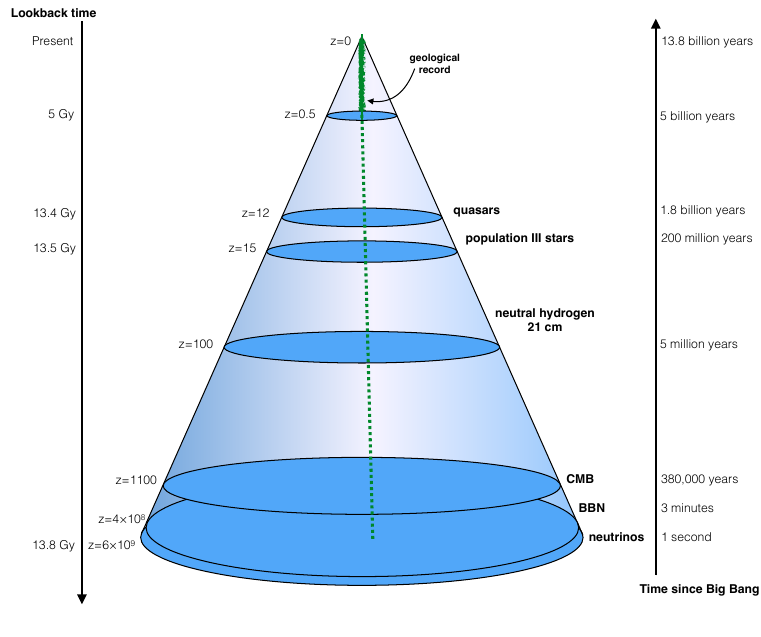
Figure 1. How we observe the universe. The lookback time is the difference between the age of the universe now, and the age of the universe when photons from an object were emitted. The more distant an object, the farther in its past we are observing its light. This distance in both space and time is expressed by the cosmological redshift z . We obtain most of our astrophysical information from the surface of our past light cone, because it is carried by photons. The only information from within the cone come from local experiments and observations, such as geological records. The green dotted line is the world-line of the atoms and nuclei providing the material for our geological data. Local experiments are carried out along this bundle of world-lines. They provide a useful test of physical constants. One example is the observation of the Oklo phenomenon [2]. The earliest information we have collected so far comes from the cosmic microwave background (CMB). Earlier than the CMB time-like slice is the cosmic neutrino background. We observe Big Bang nucleosynthesis (BBN) indirectly, through observations of the abundances of chemical